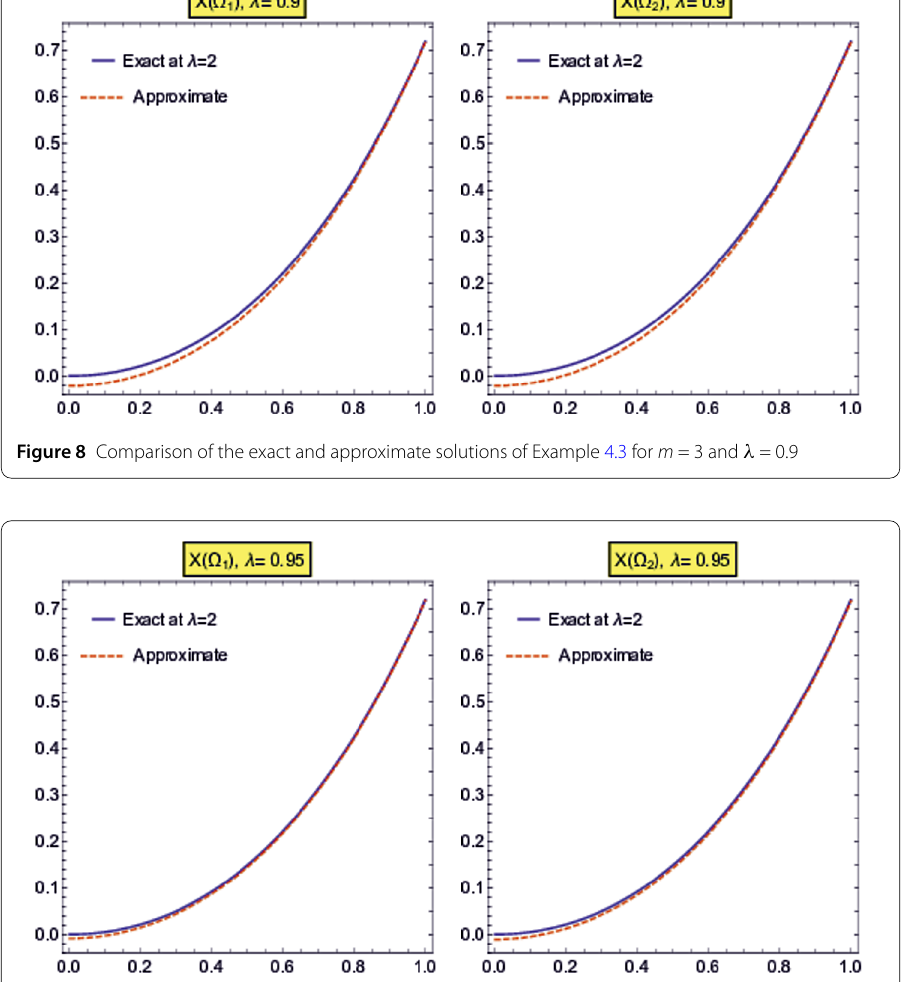
Figure 9 Comparison of the exact and approximate solutions of Example 4.3 for m = 3 and λ =